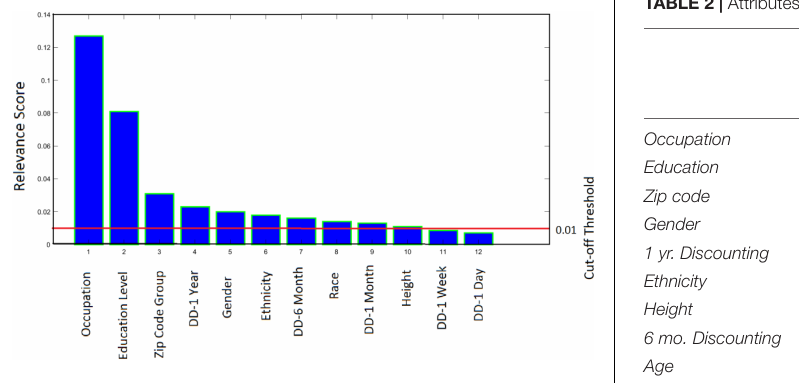
TABLE 2 | Attributes ranked according to how well they predicted salary.